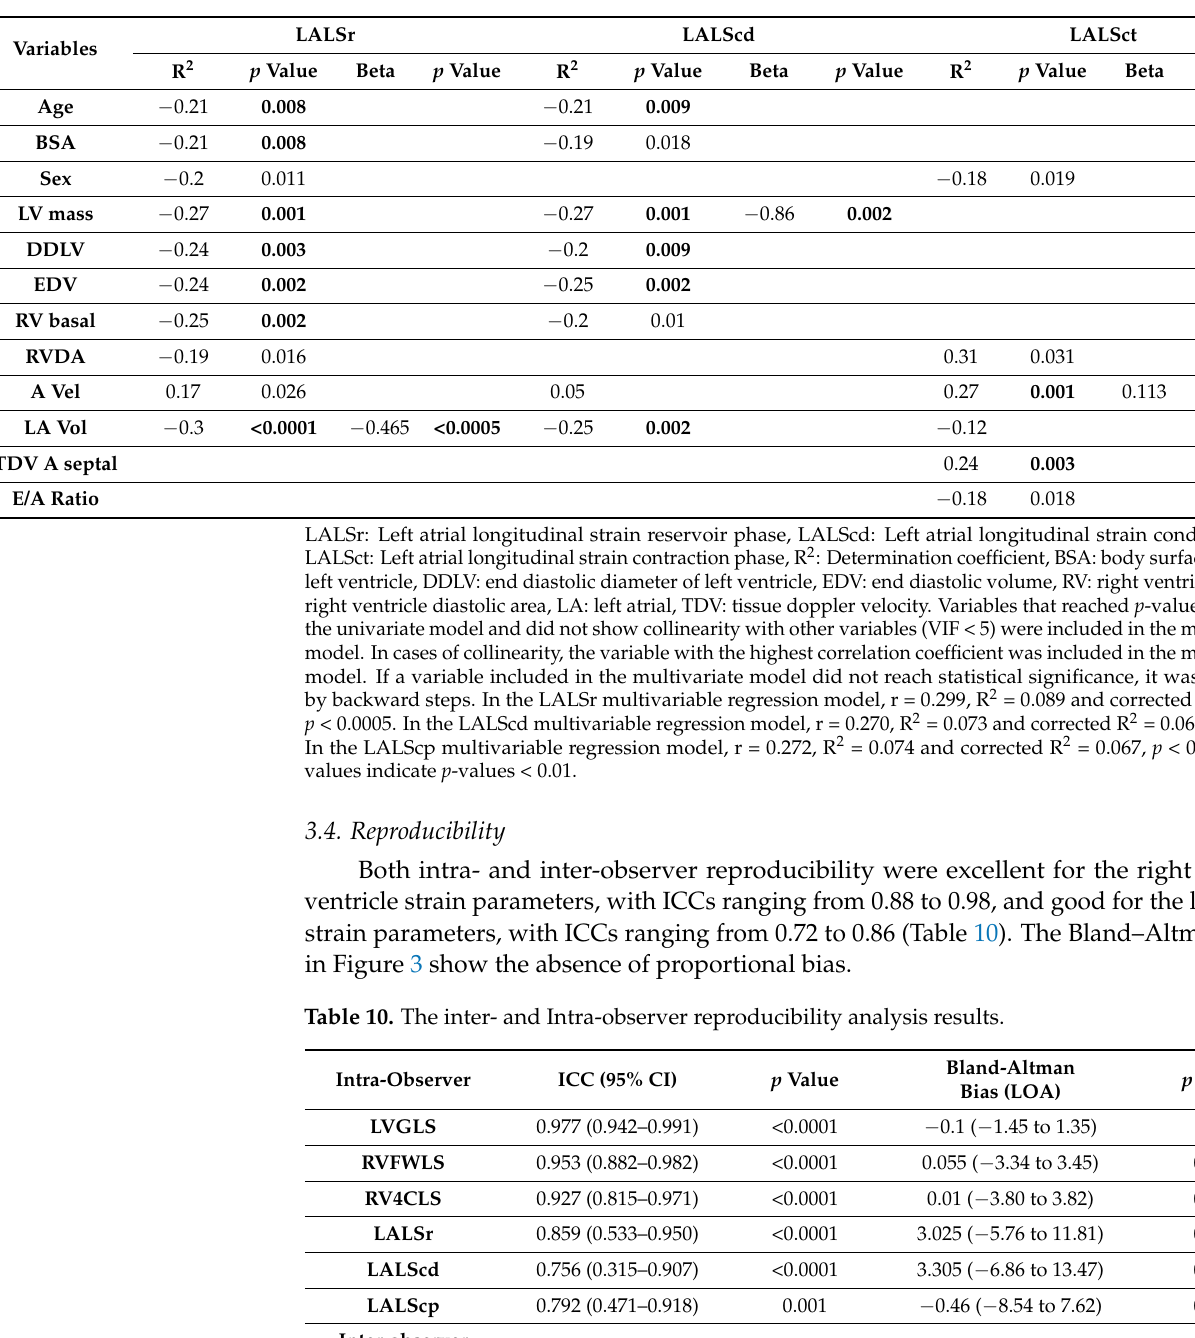
Table 9. The univariate and multivariate regression model results for left atrial strain.